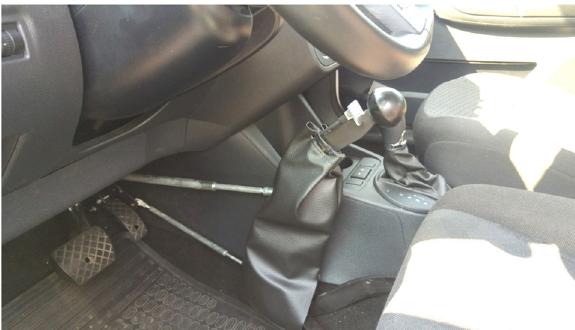
Figure 1: Vertically installed gas/brake device in driver ’ s